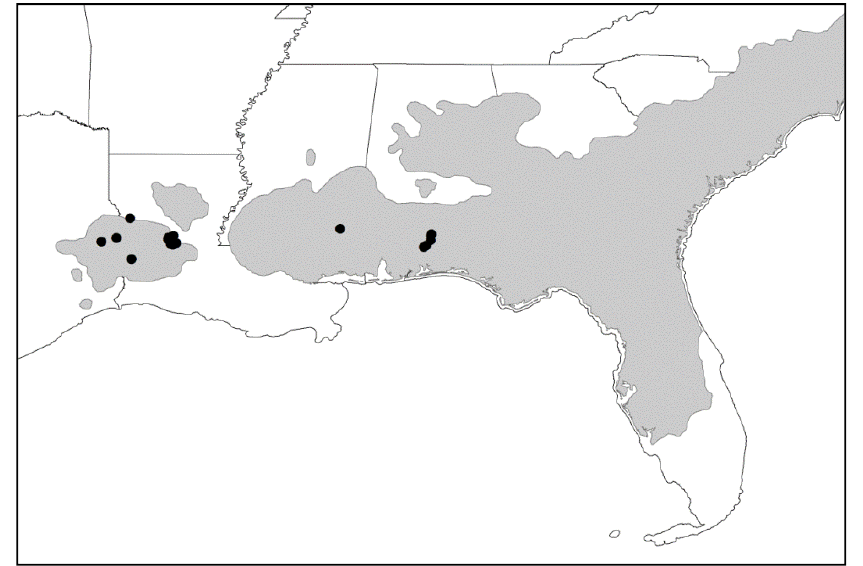
Figure 1. Location of 267 permanent plots measured within the Western Gulf Coastal Plain longleaf pine natural distribution